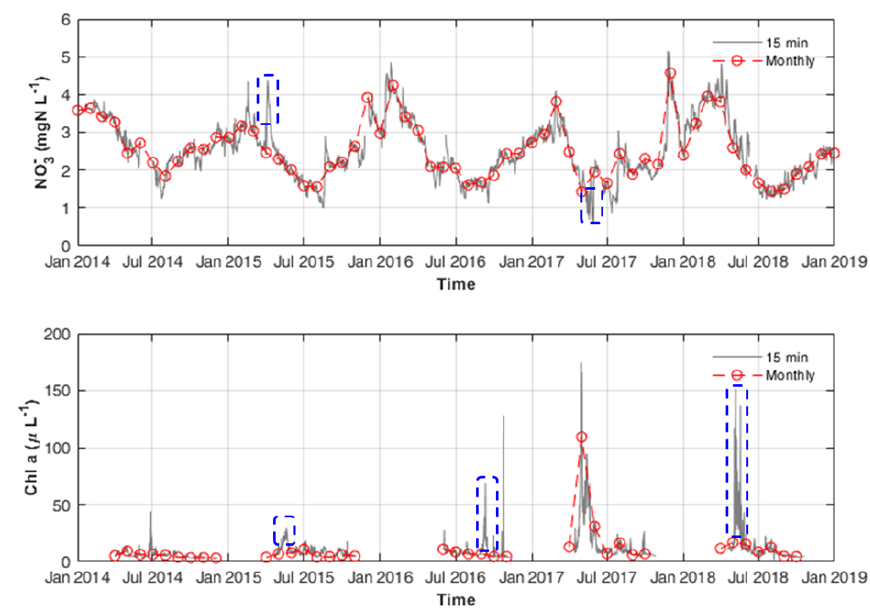
Figure 5. The 15min interval and resampled monthly NO − in the discussion given in Sect.